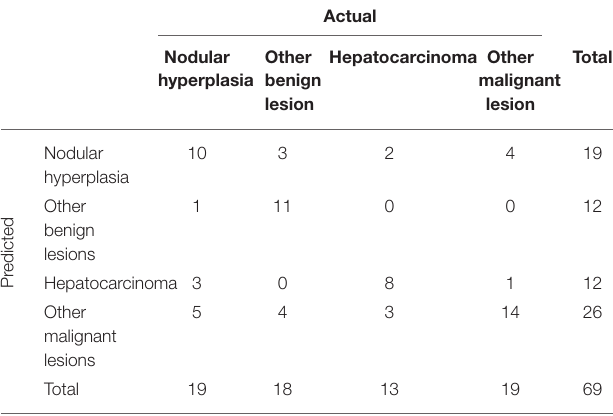
TABLE 3 | Confusion matrix to summarize the performance of the machine learning algorithm giving the number of predicted cases among the four categories of FLLs.